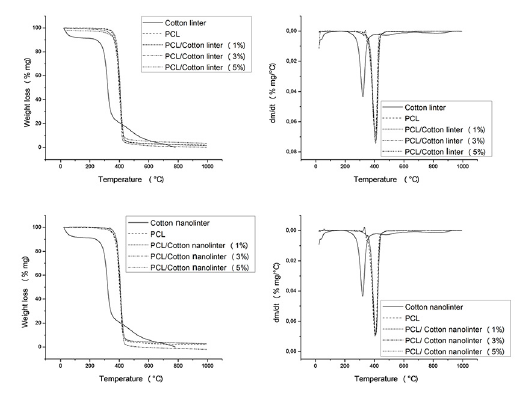
Figure 4: TG and DTG plots for cotton linter, cotton nanolinter, PCL, PCL/cotton linter and PCL/cotton nanolinter compounds. (Compositions